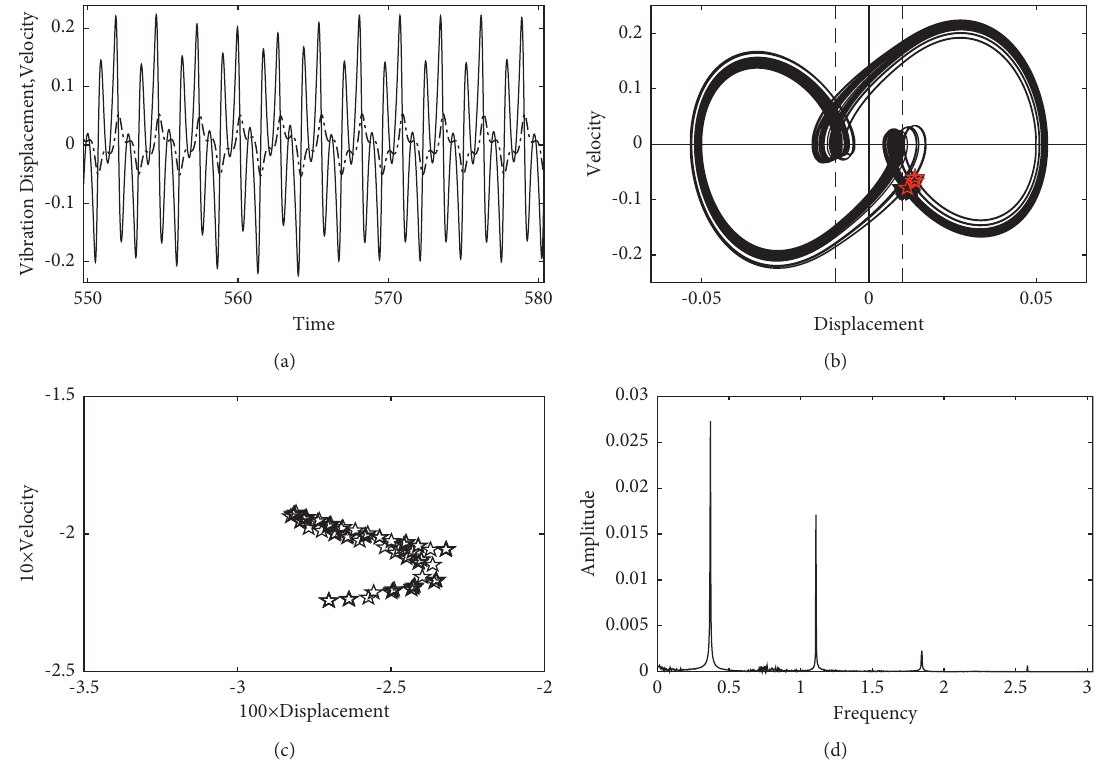
Figure 15: f � 0 . 370Hz, chaotic motion. (a) Time history graph. (b) Phase diagram. (c) Poincar´e section. (d) Power spectral density